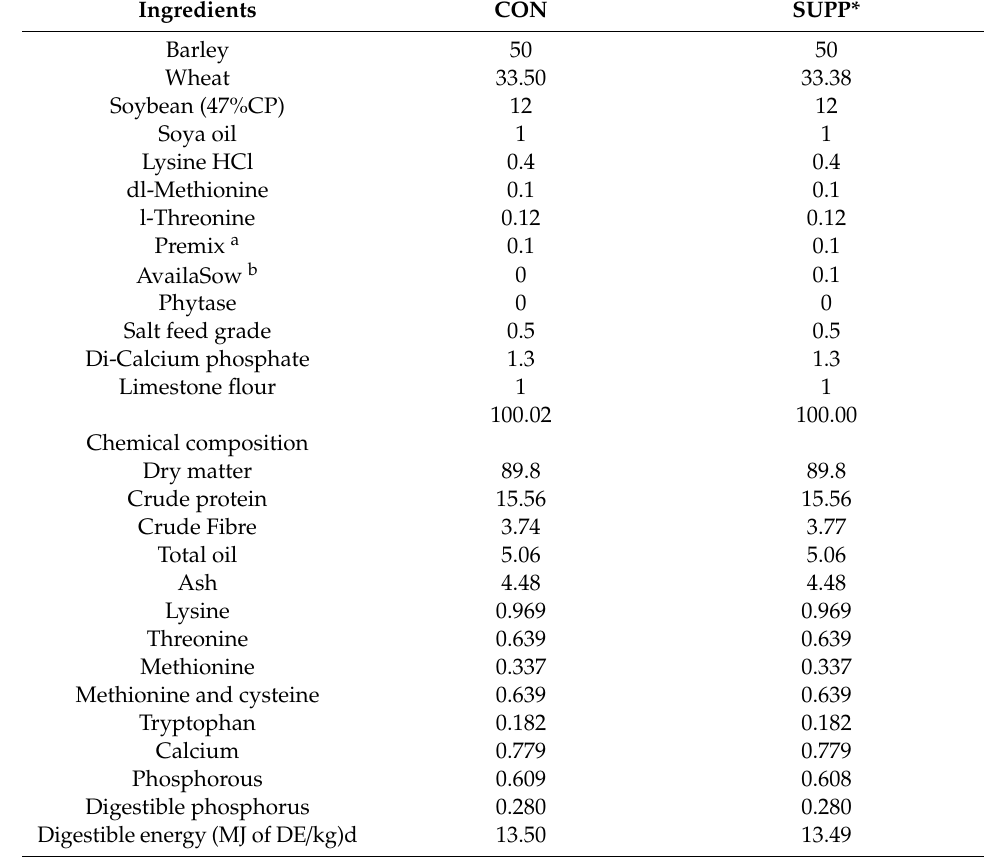
Table 1. Details of the finisher (CON; fed to all pigs) and supplemented (SUPP; from day 117.5 ± 0.6 / week 16.8 ± 0.1 of age) diets which were used in the study.